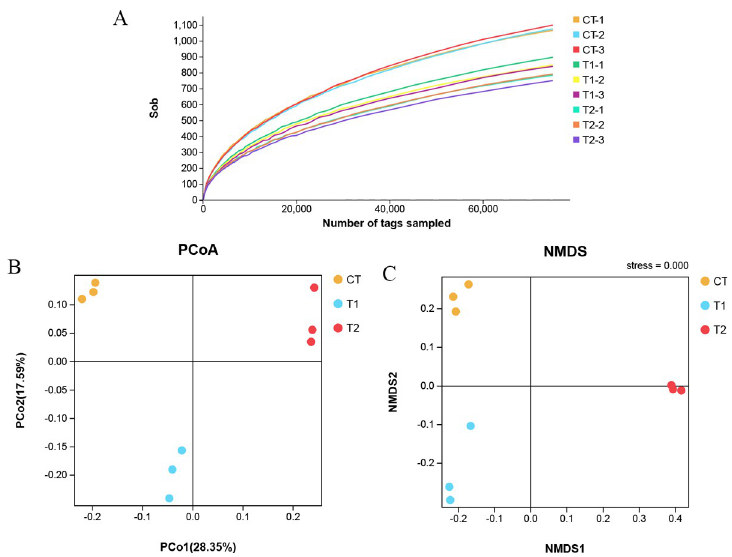
Fig 1. Distribution of the bacterial community of food waste fermentation products. Rarefaction curves of the 16S rRNA gene reads derived from the Sobs index at the operational taxonomic unit (OTU) level after normalization (A); Principal coordinate analysis of microflora in fermented food waste samples (B); Nonmetric multidimensional scaling of community structure (C). Each line and each point represent an individual sample. CT: uninoculated; T1: commercial bacterial inoculant; T2: laboratory-made bacterial